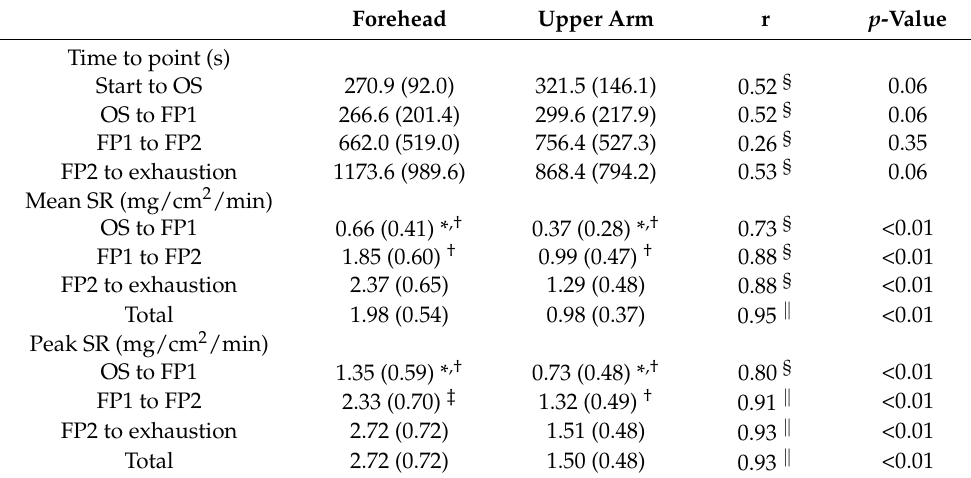
Data are presented as mean (SD). The Wilcoxon test and paired t -test demonstrated significant local differences in mean and peak sweat rates in all periods with medium to high effect sizes. Moreover, mean and peak sweat rates significantly increased in each duration (forehead, p < 0.01 using repeated ANOVA test; upper arm: p < 0.01 using Friedman test). OS, onset of sweating; SR, sweat rate; FP1, first flexion point; FP2, second flexion point. * The Bonferroni method shows a significant difference between FP1 and FP2 ( p < 0.01). † The Bonferroni method shows a significant difference between FP2 and exhaustion ( p < 0.01), ‡ ( p < 0.05), § Using Wilcoxon test, (cid:107) Using paired t -test. The mean hLSR to mean aLSR ratio in each section tended to decrease over time, although not significantly (OS to FP1, 3.18 ± 3.33; FP1 to FP2, 2.55 ± 1.38; FP2 to